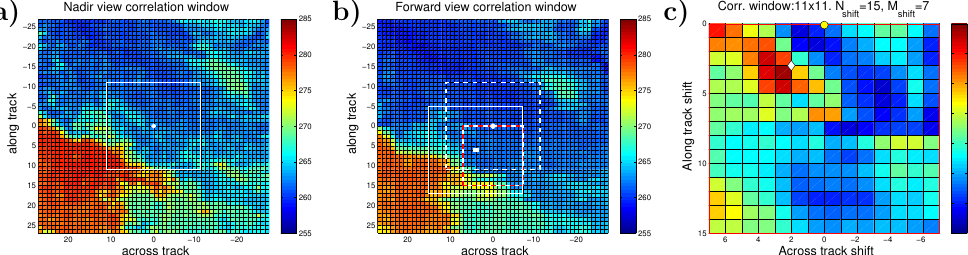
Figure 2. Illustration of the cross-correlation coefficient method using 10.85µm channel data ( T 11 ). The nadir view reference window is held in place (a) , while the center point of the forward-view target window is allowed to move within the pre-set shift window shown as the red and white rectangle (b) . The forward-view window scans all allowed shifts, and the resulting cross-correlation matrix is shown in panel (c) . The maximum value of cross-correlation coefficient C determines the best-fitting shift (m,n) selected by the algorithm. In this example, the algorithm picks shift (2, 3) as the maximum correlation